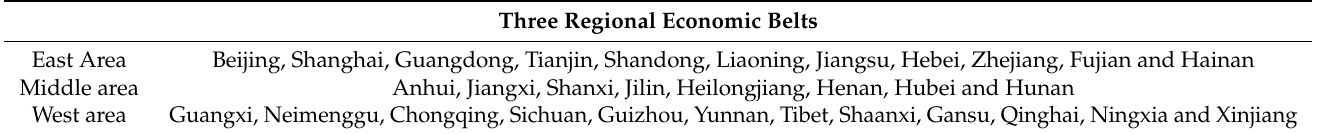
Table A1. Division of the three regional economic belts.